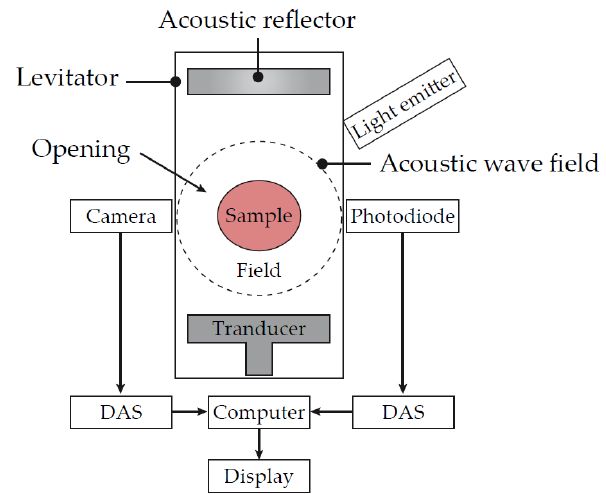
Figure 10. Schematic of the Levisonics ultrasonic transducer. The extent of shape deformations in the suspended blood droplet are directly correlated to the viscoelastic properties of the sample. As the amplitude of the standing wave is modulated, the shape of the sample will change from spherical to oblong. The camera system will track these shape changes and an algorithm converts them to viscoelastic properties. DAS = data acquisition system. Adapted from US Patent application 2017/0016878 A1 [38].